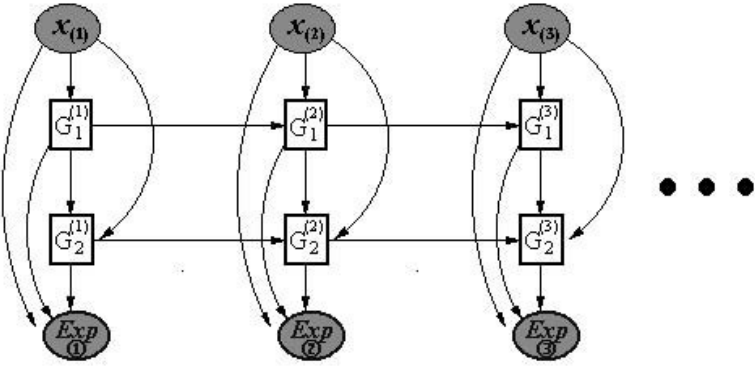
Figura 6 – Modello grafico di hidden markov decision tree (adattato da Ghahramani et al . 1997).